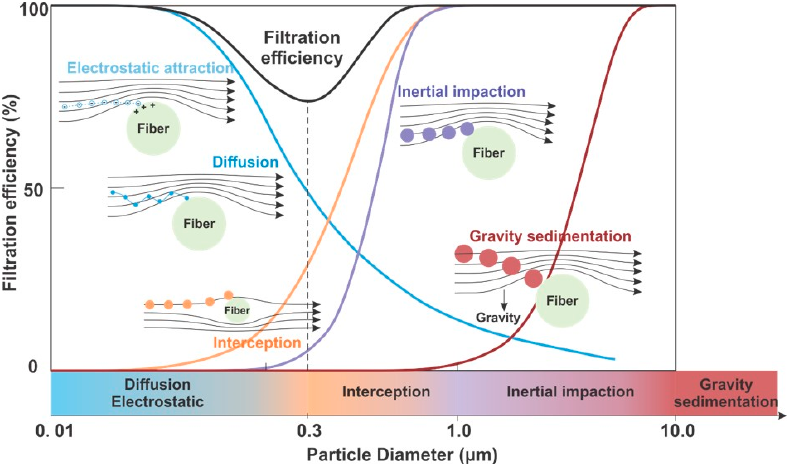
Figure 3. Impacts of particle size and type of filtration mechanism on RPD filtration efficiency.